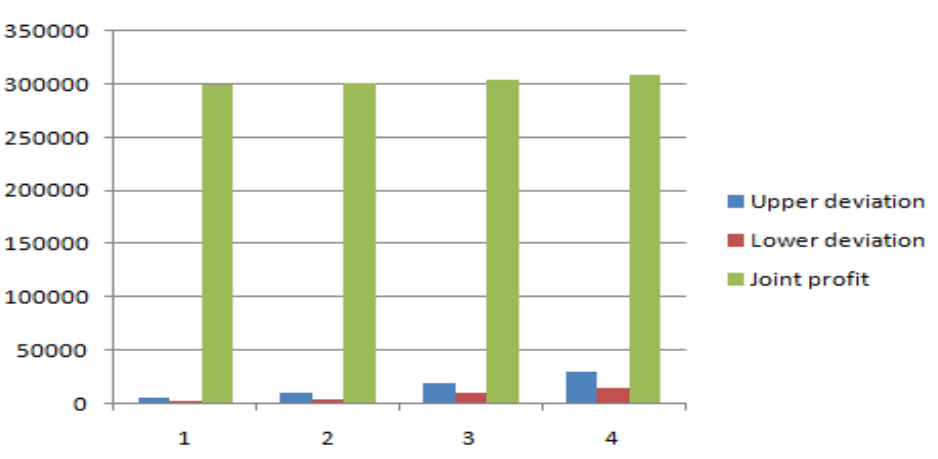
Figure 15. Upper and lower deviation of the demand rate vs. the joint total fuzzy profit.